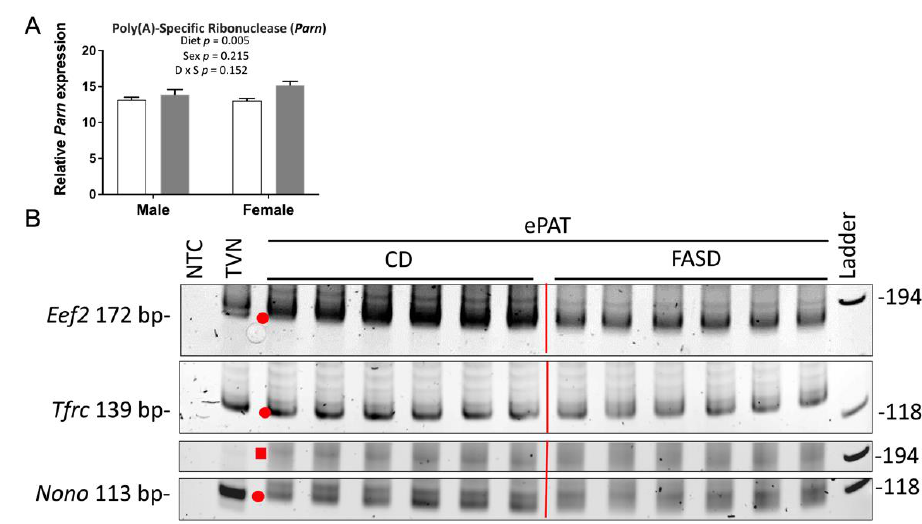
Figure 6. Expression of poly(A)-specific ribonuclease and ePAT reaction products of Eef2 , Tfrc , and Nono . ( A ) mRNA levels of poly(A)-specific ribonuclease ( Parn ) were significantly increased by FASD. Values are means ± SEM of 6 per group. White bars: CD groups; gray bars: FASD groups. p -Values from 2-factor ANOVA are indicated in the graph. ( B ) Visualization of representative PCR products of ePAT assay ( n = 6/group) for Eef2 , Tfrc , and Nono on the polyacrylamide gel. Red dots and square indicate the main ePAT products for each gene in the vicinity of the TVN amplicon or above, respectively. CD, control diet; FASD, folic-acid-supplemented diet; D: diet; S: sex; D x S: diet x sex interaction.